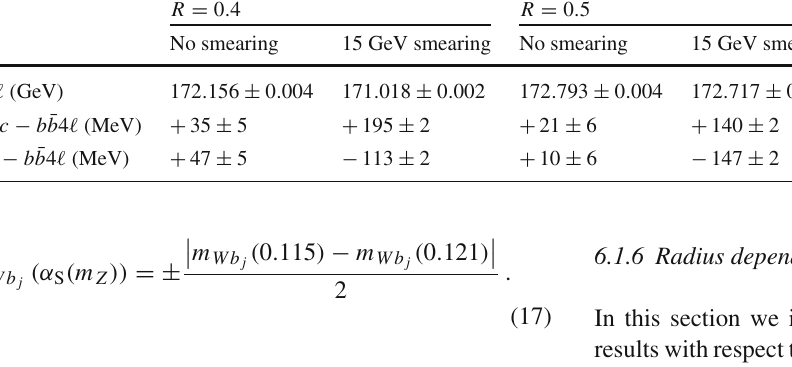
Table 7 m Wb peak position obtained with the b ¯ b 4 (cid:4) generator for three choices of the jet radius. The differences with the t ¯ tdec and the h v q j generators are also shown R = 0 .